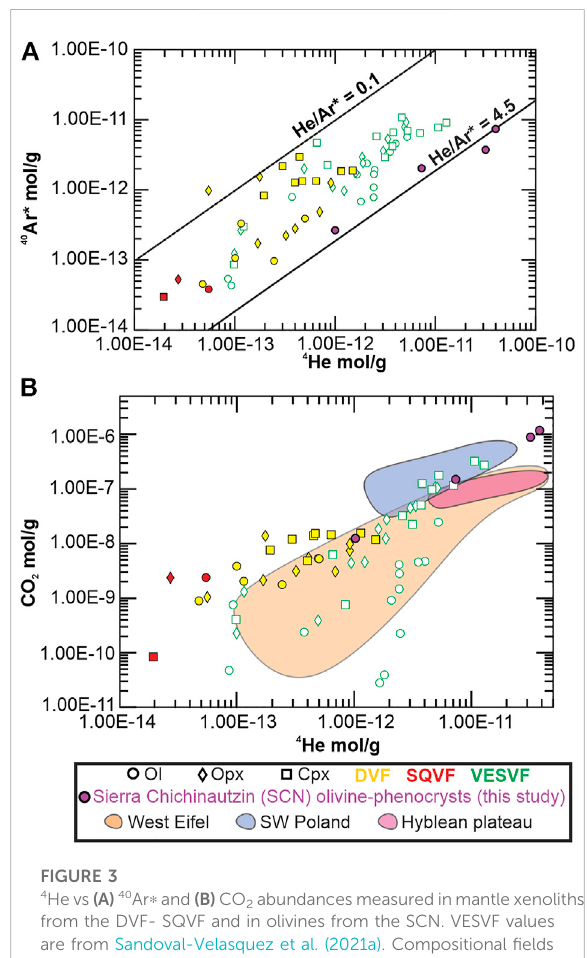
FIGURE 3 4 Hevs (A) 40 Ar p and (B) CO 2 abundancesmeasuredinmantlexenoliths from the DVF- SQVF and in olivines from the SCN. VESVF values are from Sandoval-Velasquez et al. (2021a). Compositional fi elds for the Hyblean plateau, SW Poland and West Eifel were designed after Correale et al. (2015), Gennaro et al. (2017), Rizzo et al. (2018), Rizzo et al.